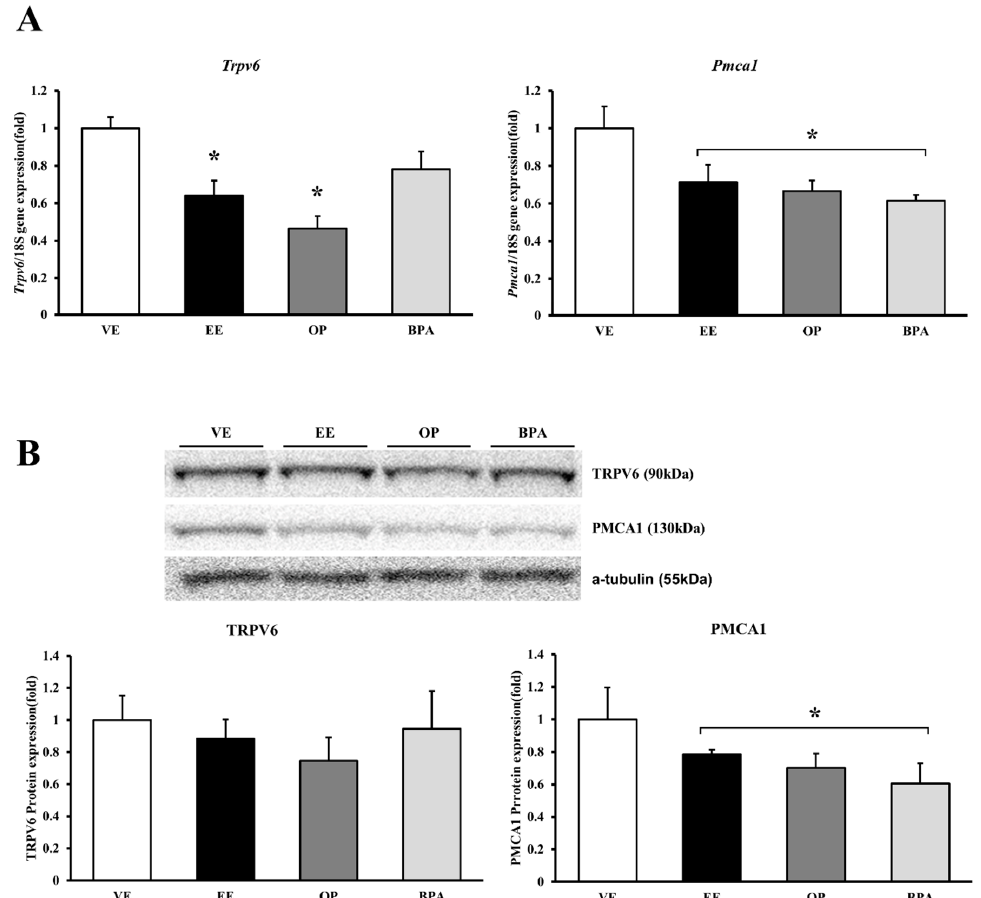
Figure 1. mRNA and protein expression of calcium transporter channel in mouse placenta. The expression of calcium-transporting channel gene was examined by real-time PCR, and normalized by Rn18S . Protein expression was examined by Western blotting. mRNA expression of Trpv6 and Pmca1 ( A ); protein expression of TRPV6 and PMCA1 ( B ). * p < 0.05 vs. VE. Data are presented as the mean ± SD. VE DMSO 5%, ethinyl estradiol (EE) 0.2 mg/kg, octylphenol (OP), bisphenol A (BPA) 50 mg/kg.